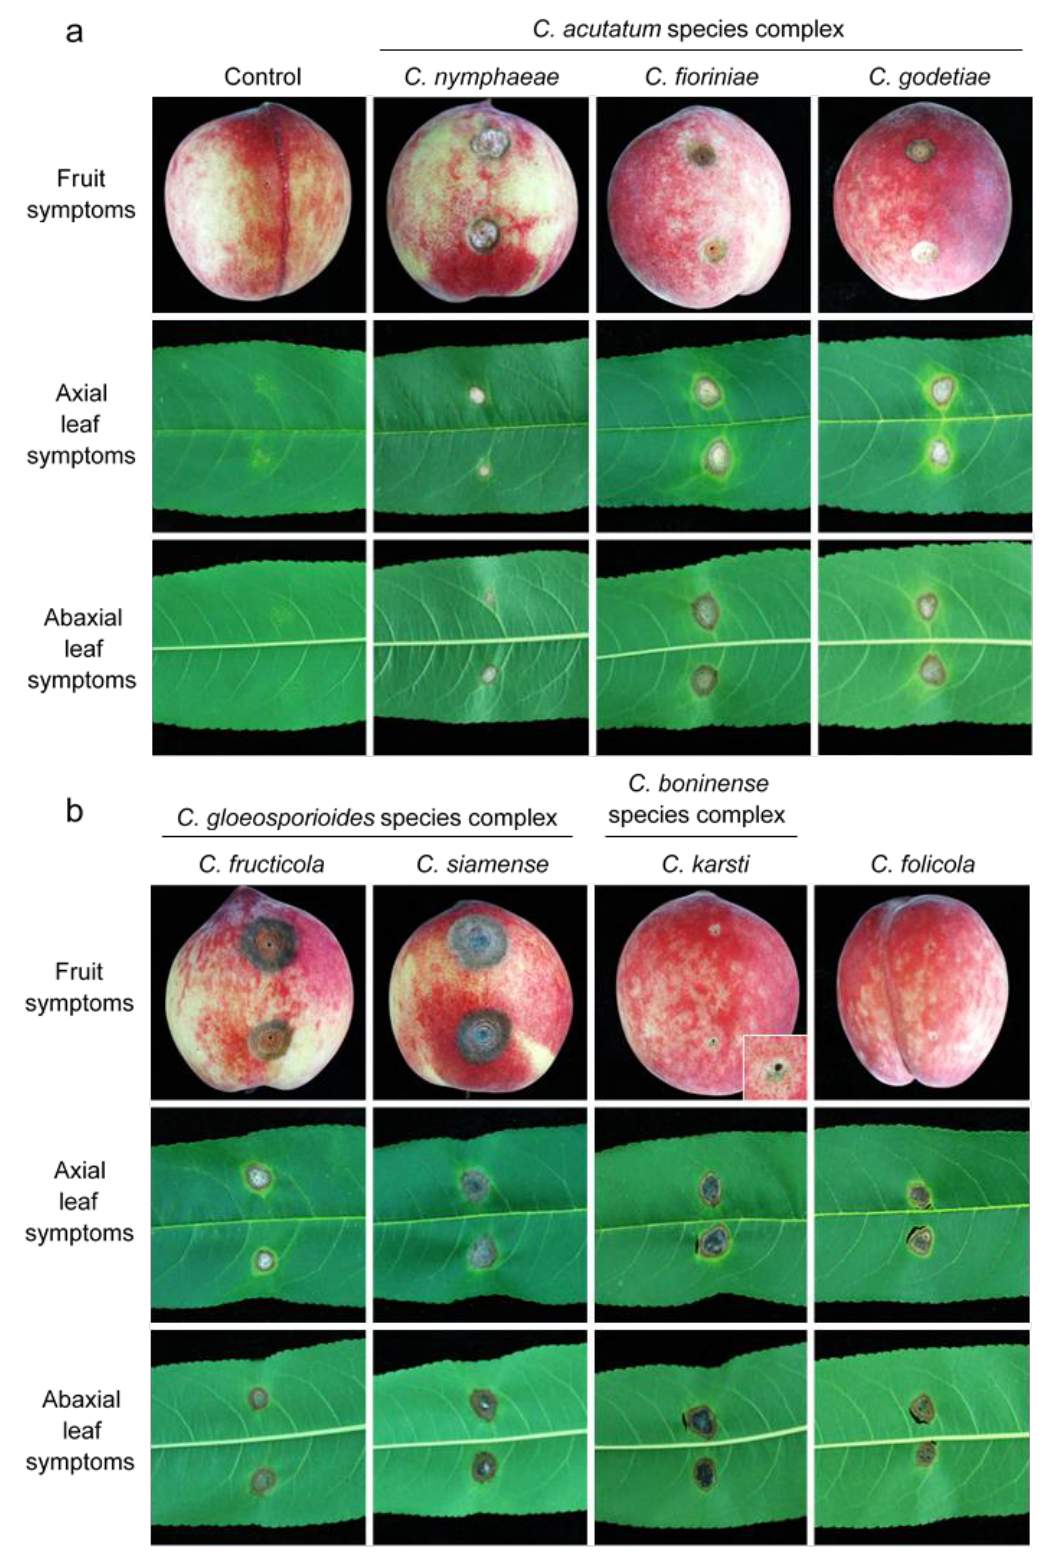
Figure 15. Symptoms of peach fruits and leaves induced by inoculation of spore suspensions of seven Colletotrichum spp. after six days at 25 °C. ( a ) Symptoms resulting from H 2 O, isolates HBYC 1, JXJA 6, and YNHH 1-1 ( left to right ). ( b ) Symptoms resulting from isolates GDHY 10-1, SDQD 10-1, YNHH3-1, and YNHH10-1 ( left to right